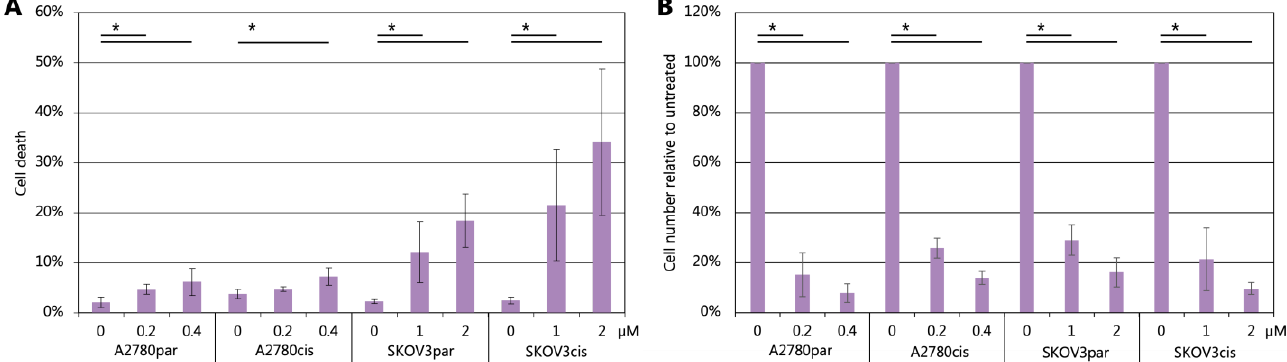
Figure 1. Flow-cytometry-based analysis of cell death ( A ) and fraction of alive cells relative to un- treated cells ( B ) after treatment with compound 7 with indicated concentrations in µM (Student´s t - test, mean +/ − standard deviation of ≥ 3 replicates , * p < 0.05).